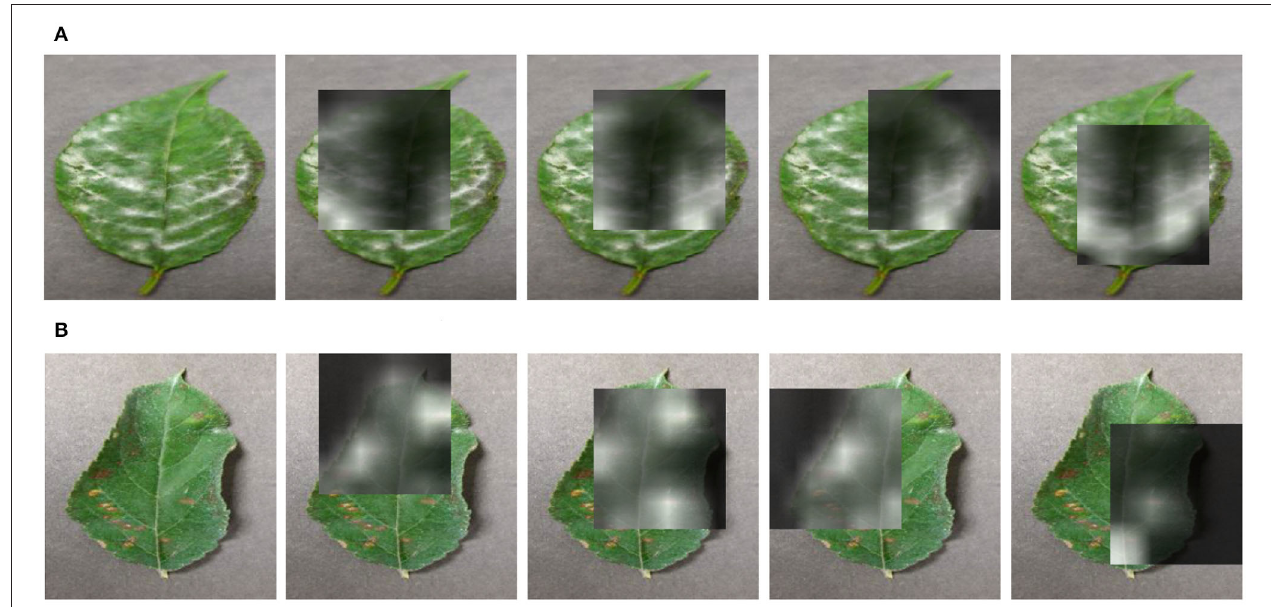
FIGURE 1 | The learned attention maps by our proposed approach on two diseases that have contaminated leaves. The visualizations highlight the infected regions. (A) Powdery mildew disease, on cherry plant. (B) Cedar apple rust disease, on